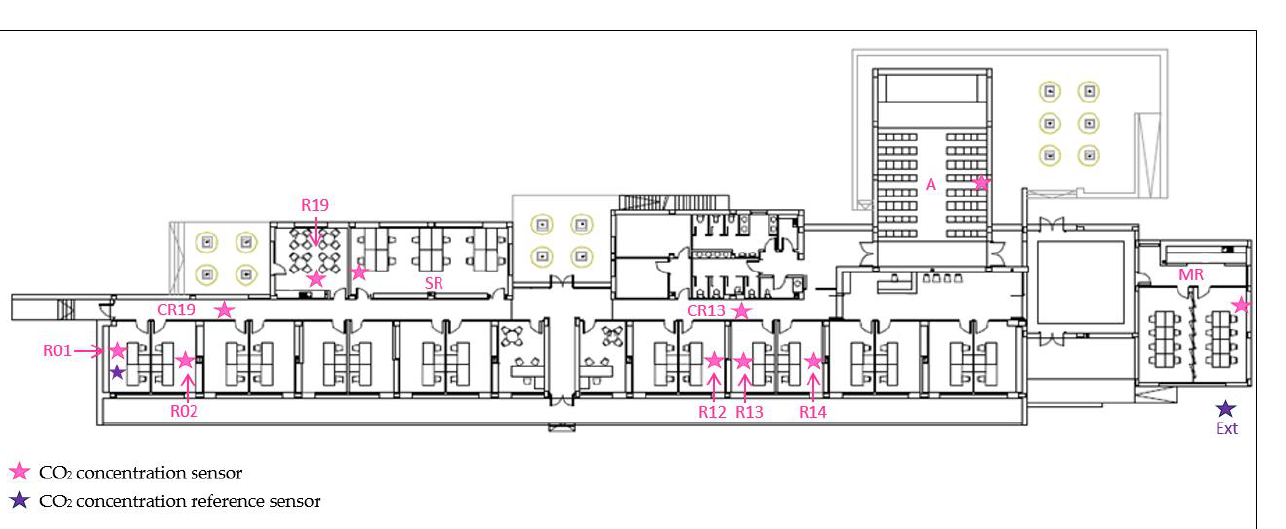
Table 1. Types of sensors used in this analysis and summary of their characteristics.